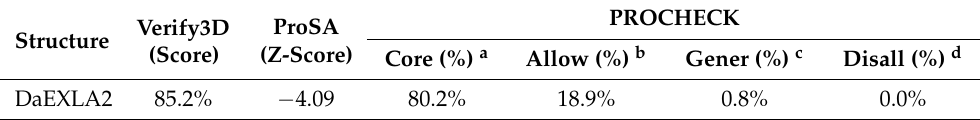
Table 2. Evaluation of DaEXLA2 structure after MD simulations and system equilibration.